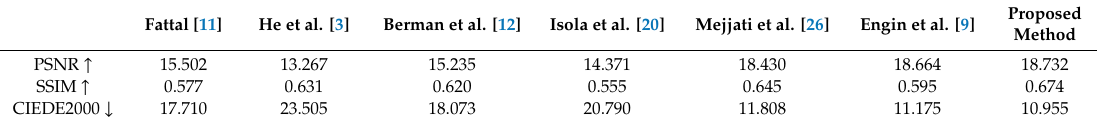
Table 1. Evaluation of quantitative indicators. This table lists the average peak signal-to-noise ratio (PSNR), structural similarity (SSIM), and CIEDE2000 [28,29] index results of 45 images from the O-HAZE [10] dataset using di ff erent models and methods. Our results are superior to those of other methods on the basis of these